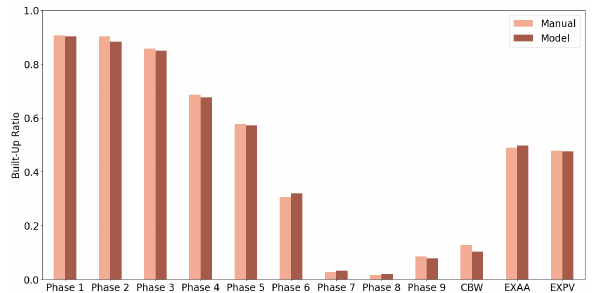
Figure 6. Spatial Consistency of the model: The results for spa- tial consistency performance of our model. On x-axis, we have different regions of DHA and on y-axis we show the estimated and ground truth BRs for that region.